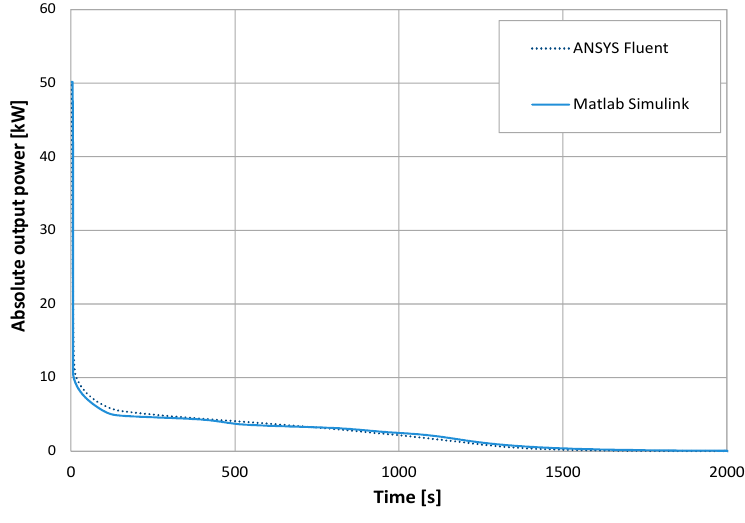
Figure 4. Comparison of equidistant allocation in ANSYS Fluent and MATLAB Simulink.